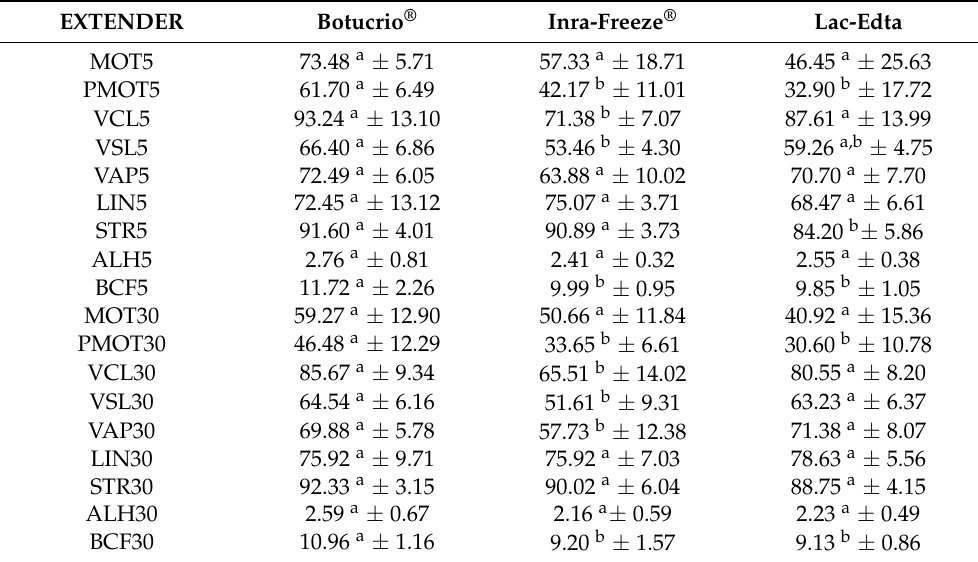
Table 3. Motility parameters 5 and 30 min after thawing for freezing extenders in SC group. EXTENDER Botucrio ® Inra-Freeze ® Lac-Edta MOT5 73.48 a ± 5.71